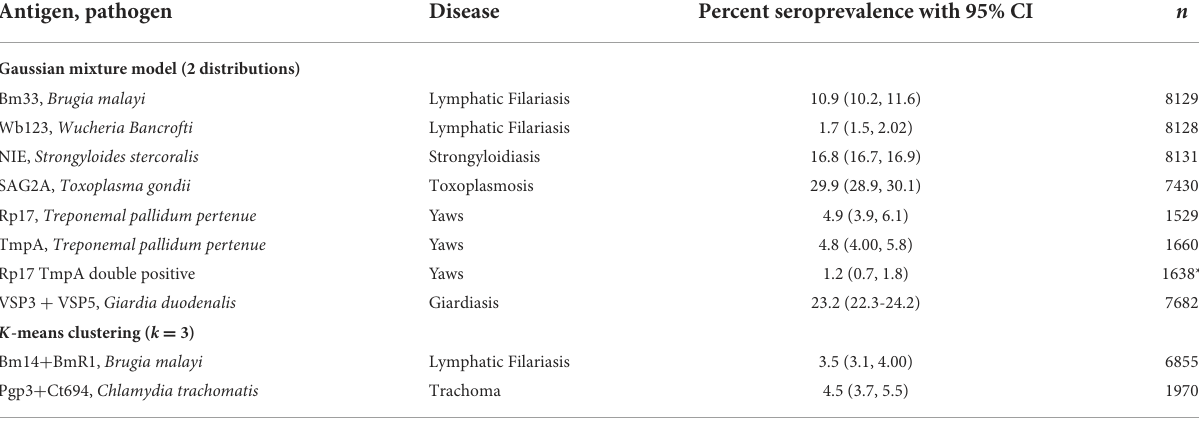
TABLE 2 Study site characteristics. median fluorescent intensity (MFI) of wells achieving at least a